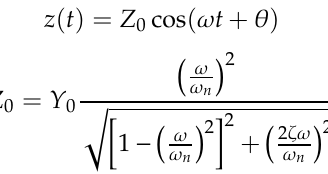
Figure 10. Sensor output signal V out , versus amplitude, Y pp , of vibration of the energy harvester (sensor solidary vibrating with the vibrating platform).